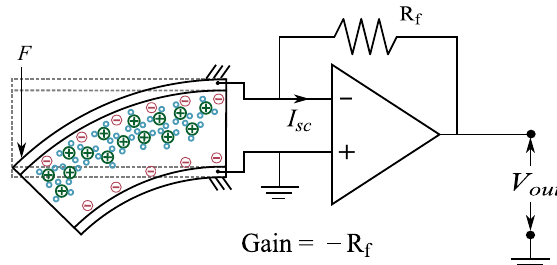
Figure 8. Principle implementation of IPMC current